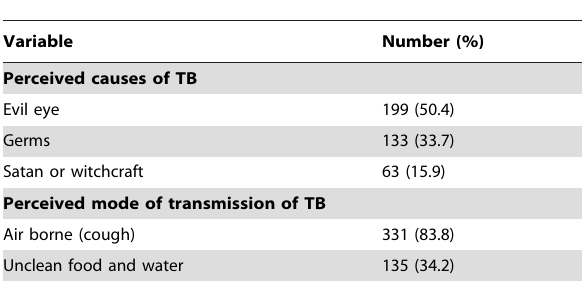
Table 2. Knowledge about TB among TB suspects (n=395) in the Gilgel Gibe field research area, south west Ethiopia, March